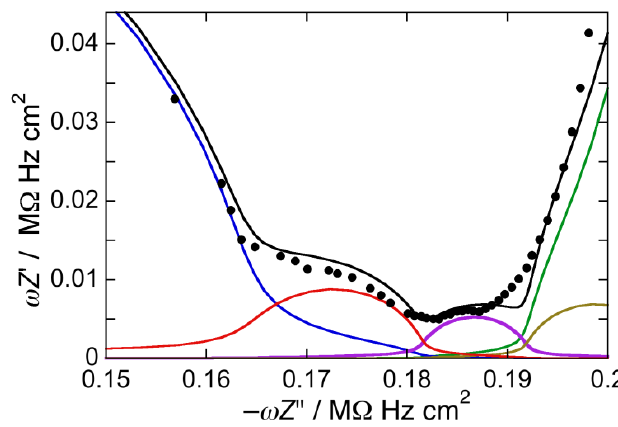
Figure 4. Plot of ω Z ′ against −ω Z ″ for a Hg-supported DOPC/Chol/PSM/GM1 (47:21:12:20) mol% monolayer in aqueous 0.1 M KCl at − 0.550 V. Solid circles are experimental points and the black curve is the best fit to these points by a series of five RC meshes. The contributions to ω Z ′ against −ω Z ″ are represented in blue for the hydrocarbon tails, in red for the polar heads, in brown for the diffuse layer, in green for the aqueous solution, and in violet for an additional R C mesh, ascribed to the “inner layer”. il il Capacitances and resistances of the five RC meshes are: R = 1.6 M Ω ·cm 2 , C = 6.1 µF cm − 2 , ht ht R = 3.4 k Ω ·cm 2 , C = 57 µF·cm − 2 , R = 1.6 Ω ·cm 2 , C = 73 µF·cm − 2 , R = 3.5 Ω ·cm 2 , ph ph dl dl Ω C = 27 nF·cm − 2 , R = 50 Ω ·cm 2 , C = 90 µF·cm − 2 Ω il il